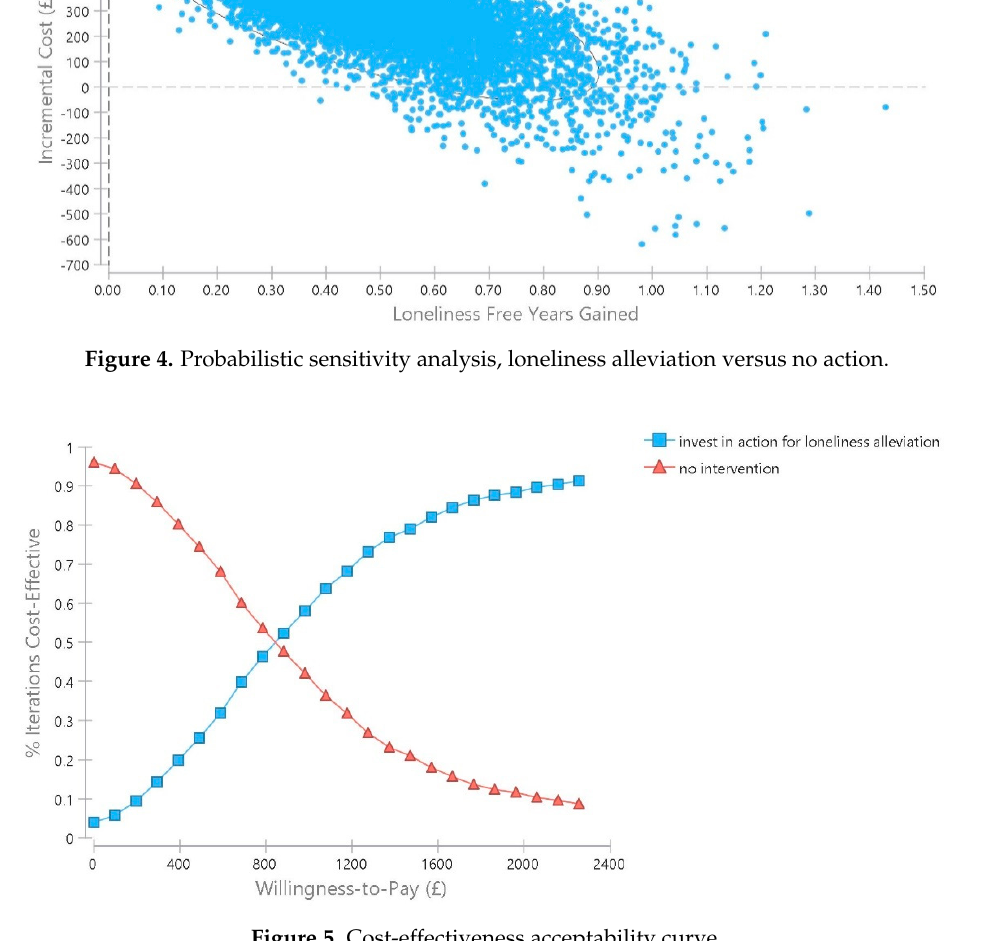
Figure 5. Cost-effectiveness acceptability curve.